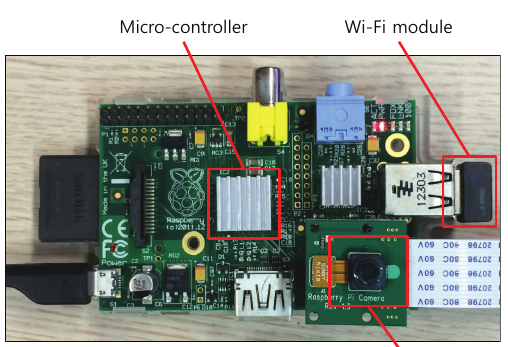
Figure 7. Secured IoT device